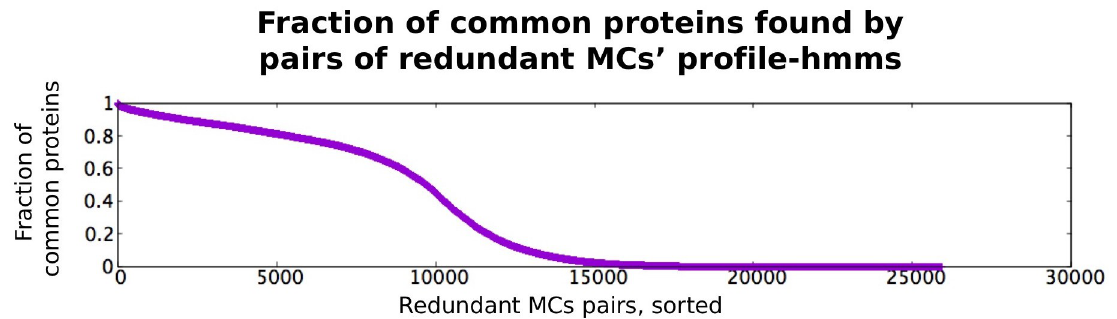
Fig 5. Comparison between areas of sequence space covered by MCs in fully redundant pairs. Note that we exclude MC pairs in parent- child relationships and are left with 25,980 pairs overall. For each MC, we generate the list of IDs of all proteins that map to at least one MC member (using the profile-HMM-based definition of MC membership, see Methods). Then, for each pair, we calculate the fraction of protein IDs that are shared between the two MCs (where the fraction is calculated with respect to the MC with the shorter protein ID